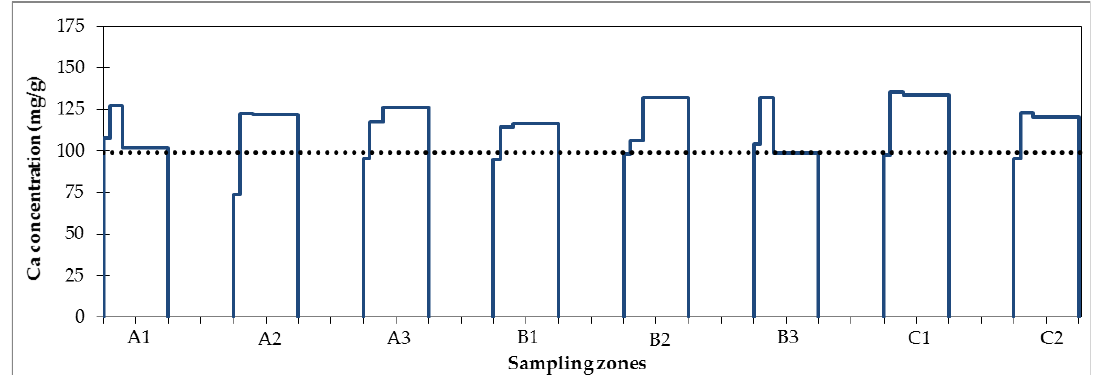
Figure A3. Concentrations of calcium measured in composite cores of each sampling zone. Within each zone, concentrations from cores taken at depths of 0–5 cm, 5–15 cm and 15–50 cm are represented to scale from left to right. The dotted line represents the concentration measured in the initial soil sample.